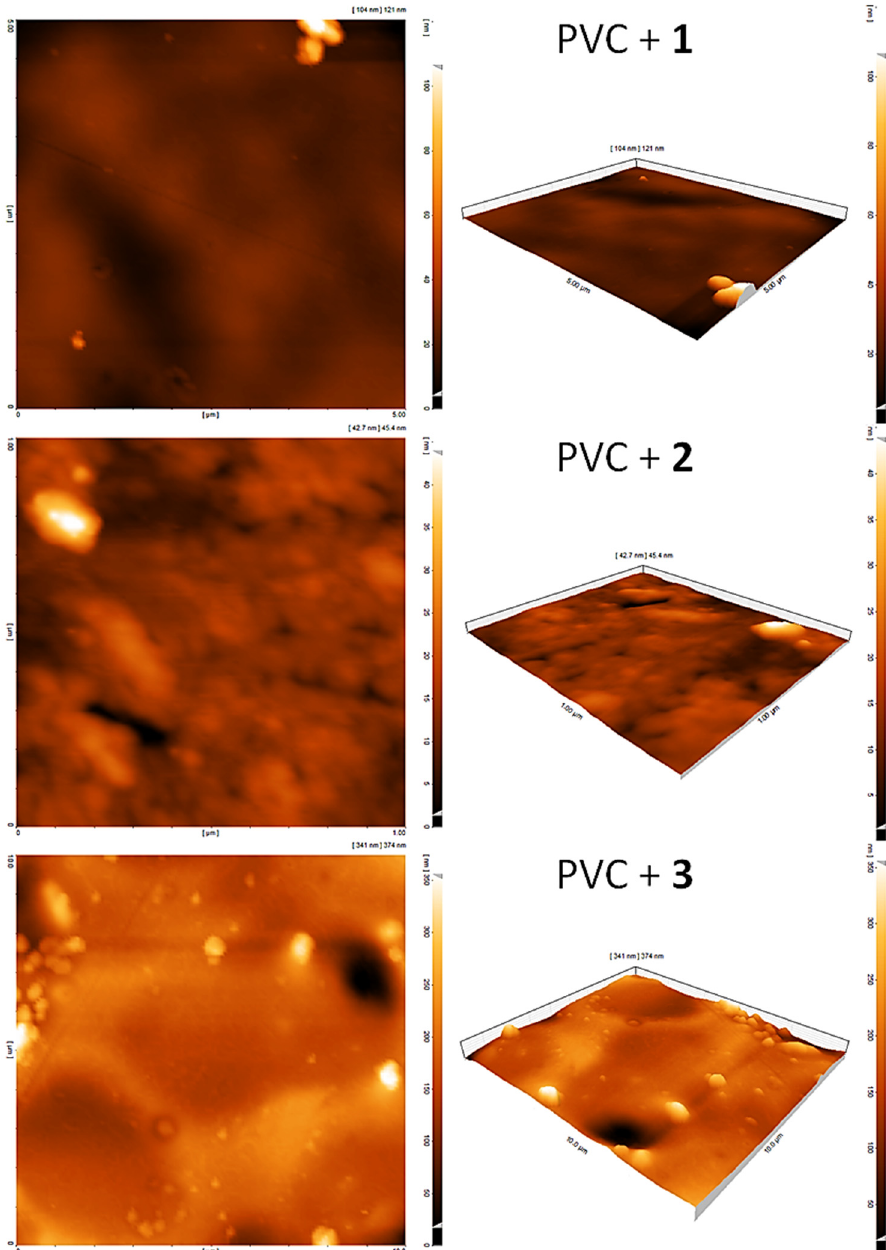
Figure 10. AFM images of PVC films after irradiation.